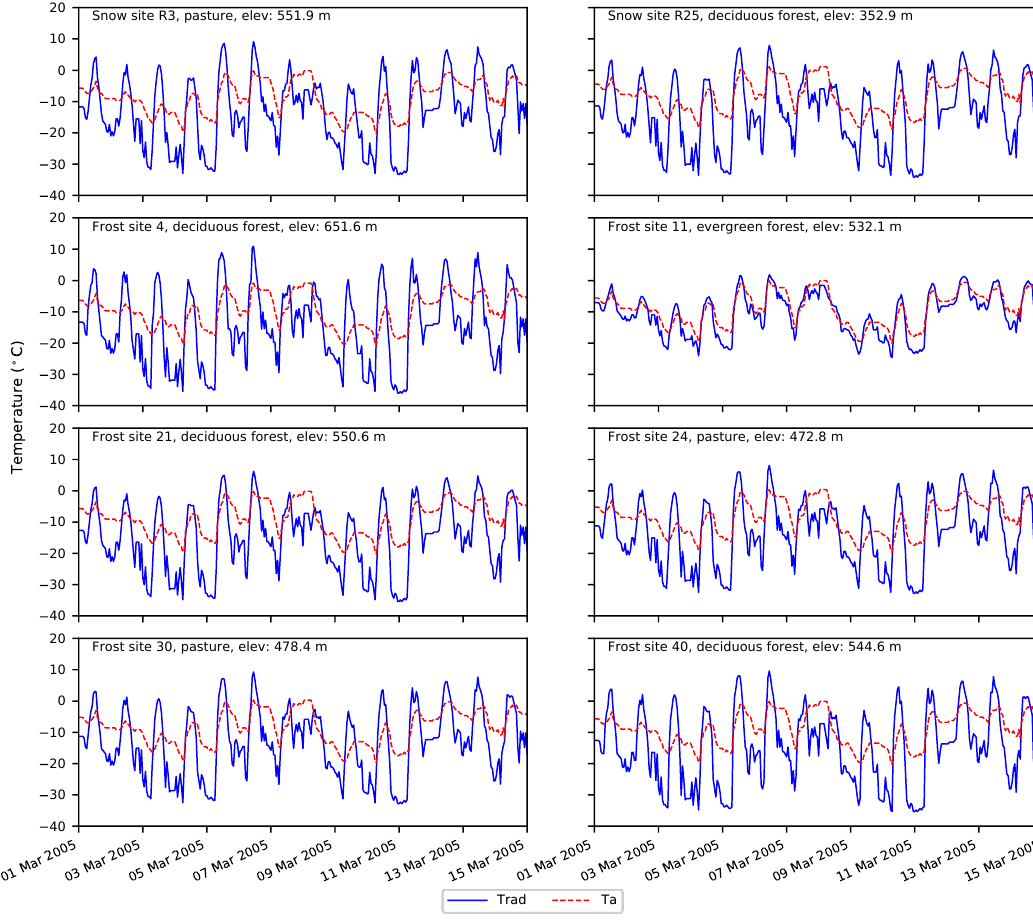
Figure 4. T a and T rad values at all eight test sites within the W-3 watershed between 1 and 15 March 2005.